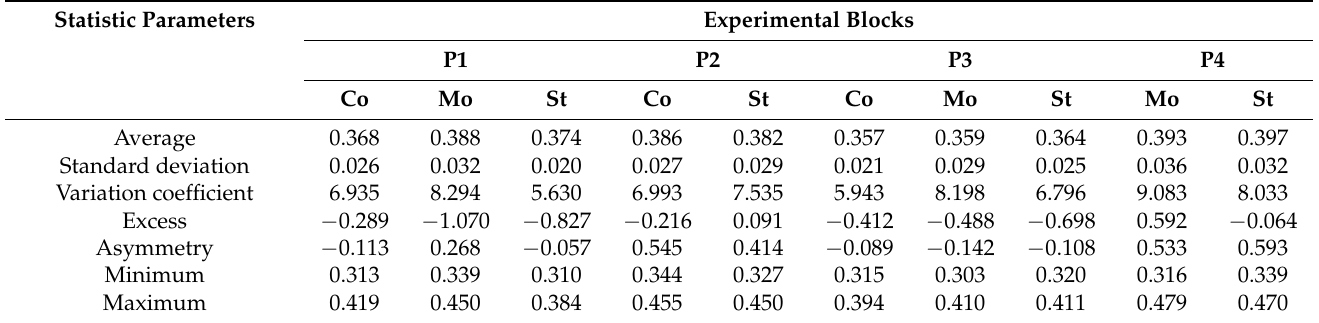
Table 2. The general statistical parameters (average, standard deviation, variation coefficient (%), asymmetry, excess, minimum and maximum) for density (g · cm − 3